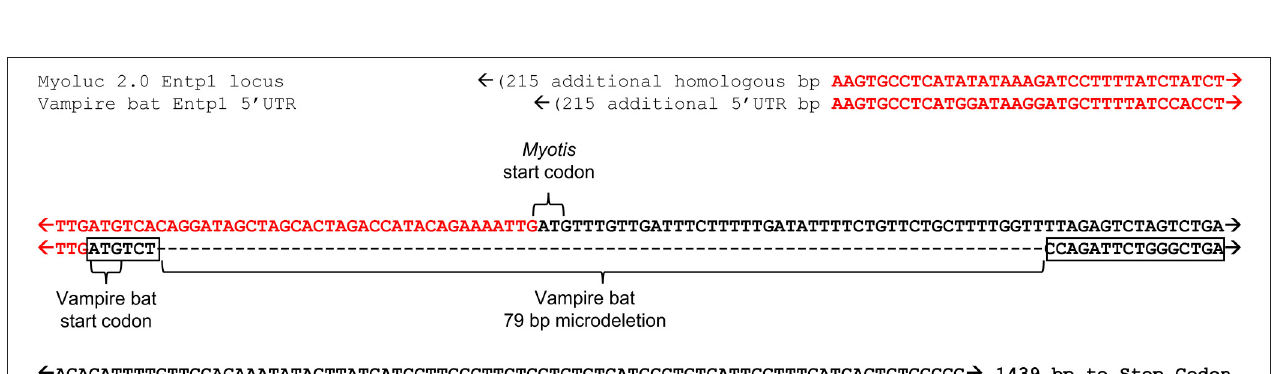
FIGURE 2 | Alignment of Entpd1 5 ′ region between vampire bat and M. lucifugus (dashed box in Figure 1). Sequence of vampire bat 5 ′ UTR and orthologous M. lucifugus genomic coordinates are displayed in red font and the location of the vampire bat mRNA sequence encoding the secretory signal peptide sequence is boxed. The 79 bp microdeletion observed in vampire bat, which results in the N-terminal location of the novel secretory signal peptide sequence, maintains downstream reading